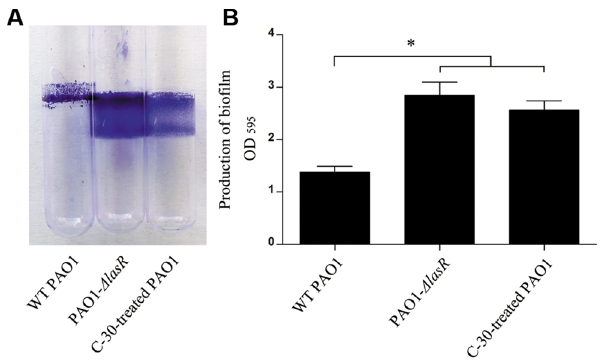
Figure 7. High levels of rsmY and rsmZ expression could cause an enhanced biofilm production after 24 h. Production of biofilm was detected by crystal violet staining (A) and quantified at OD 595 (B). The data are represented as means 6 SEM, six replicates per culture. *, P , 0.05, one-way ANOVA (Tukey-Kramer post hoc).